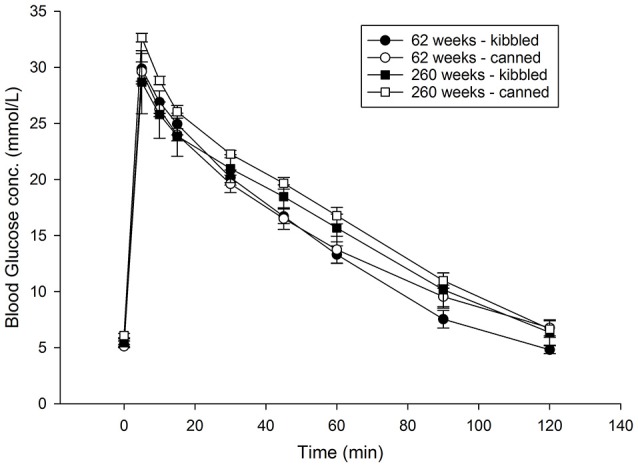
Blood glucose concentrations following an intravenous glucose tolerance test (IVGTT) in domestic cats (Felis catus) fed either kibbled (n = 8) or canned (n = 8) diets at 62 and 260 weeks of age. Results are reported as means and error bars represent the standard error of the mean.